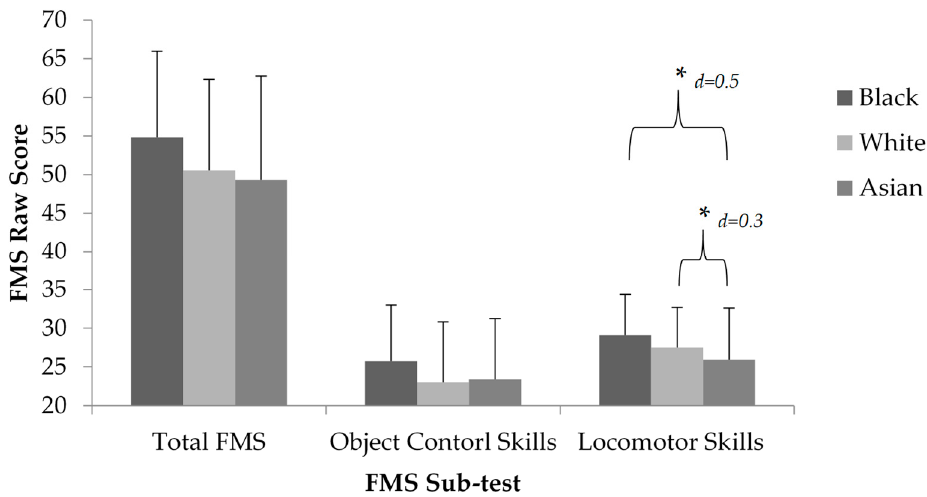
Figure 3. FMS proficiency scores (mean ± standard deviation) by ethnic group (Black vs. White vs. Asian) of total FMs, object control skills, and locomotor skills. * Indicates significant difference between ethnic group p < 0.05.